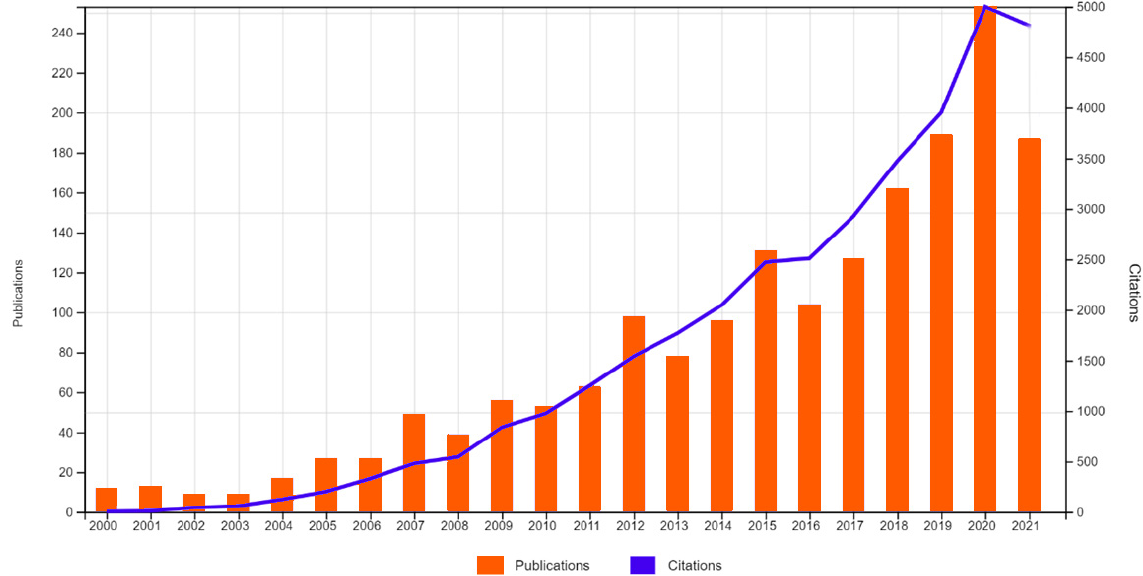
Figure 1. Number of publications and citations per year. Source: Web of Science (adapted). With respect to the number of citations of the articles included in the analysis, these were cited 35,455 times, 32,932 when excluding self-citations. The maximum number of citations in a single year was in 2020 (5000 citations), coinciding with the greater number of publications. The five most productive years were, from most to least, the following: 2020, 2019, 2021, 2018, and 2015 (see Table